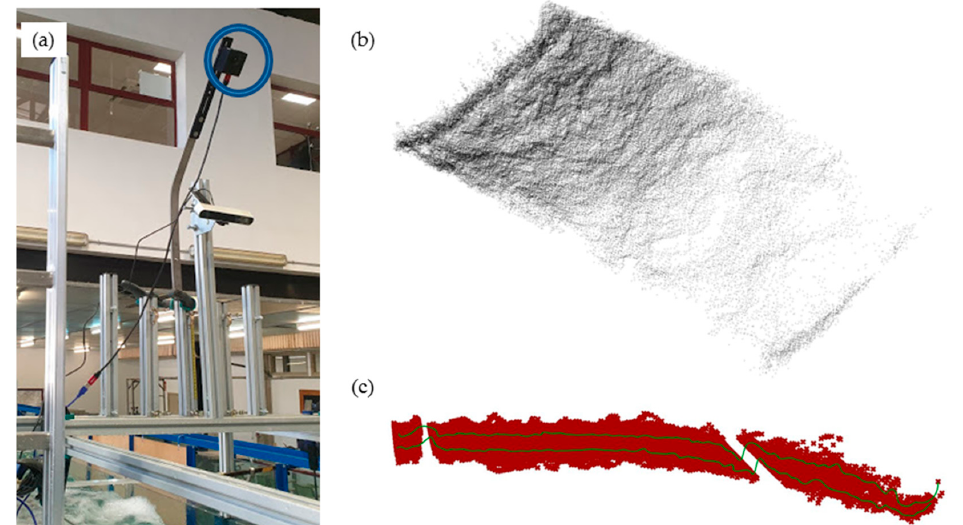
Figure 3. Light detection and ranging (LIDAR) techniques in the physical model (flow from right to left): ( a ) Time-of-flight camera placed in the experimental device; ( b ) point cloud obtained from the hydraulic jump free surface; ( c ) band containing 80% of the measured points.